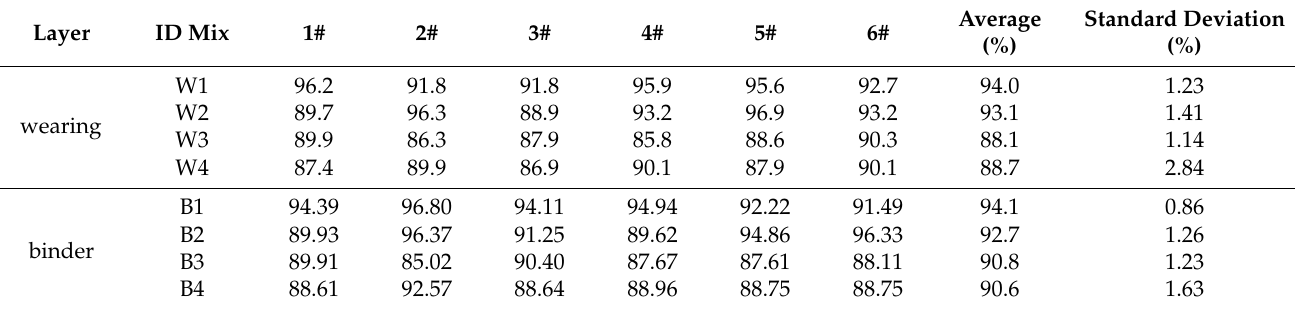
Table 5. ITSR values of the